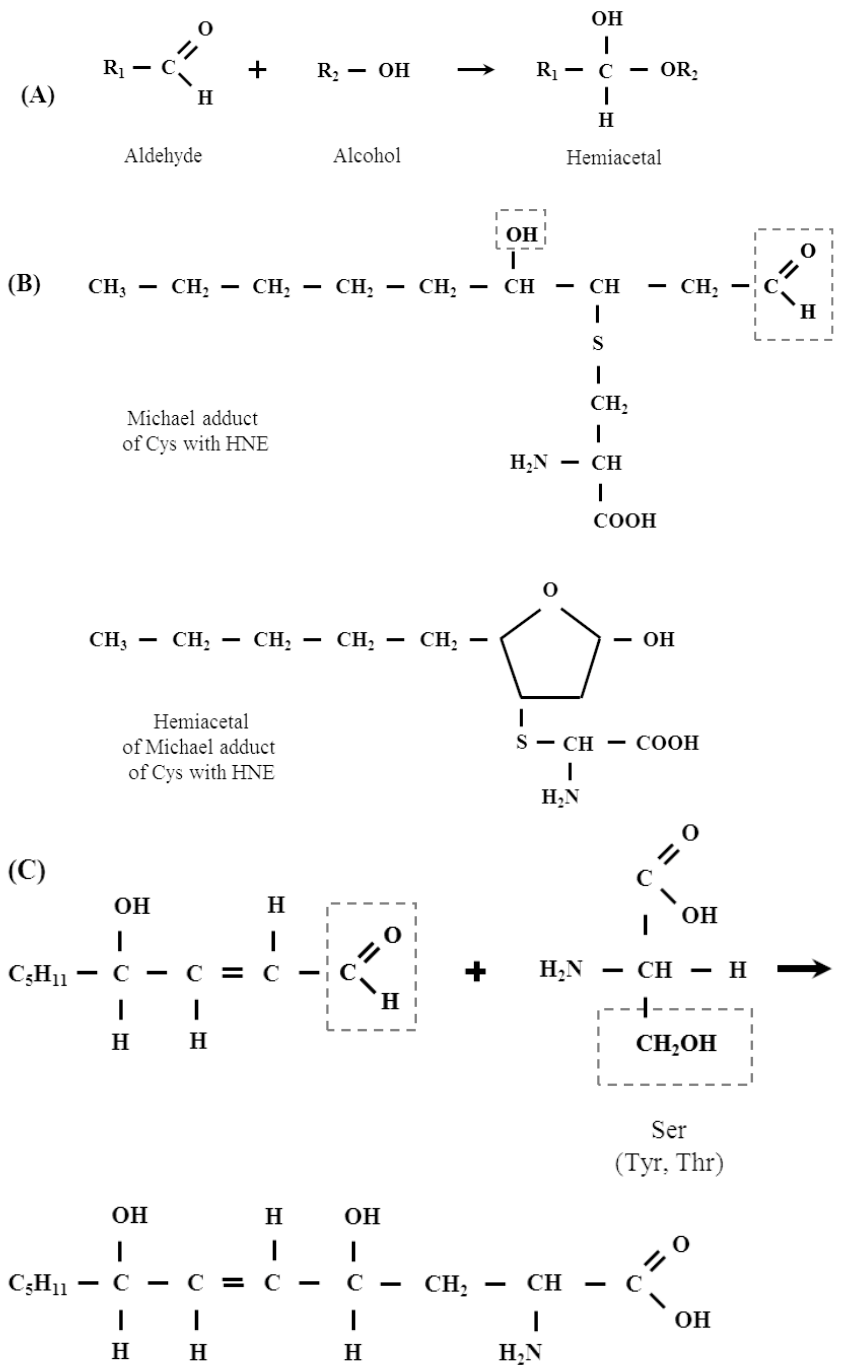
Figure 4. ( A ) The mechanism of hemiacetal formation in the reaction of an alcohol with an aldehyde. ( B ) Hemiacetal formation from the reaction of Michael adduct of Cys with HNE. ( C ) A plausible mechanism of the formation of the hemi- and thiohemiacetals in the reaction of HNE with Ser, Tyr, Thr and Cys residues present in the polypeptide chain.